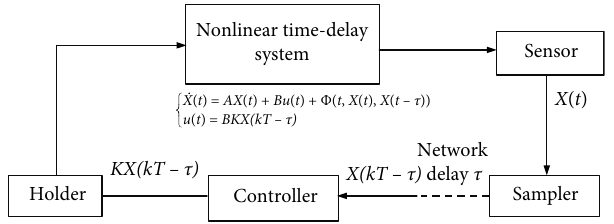
Figure 1: Structure of the nonlinear network system via sampled- data